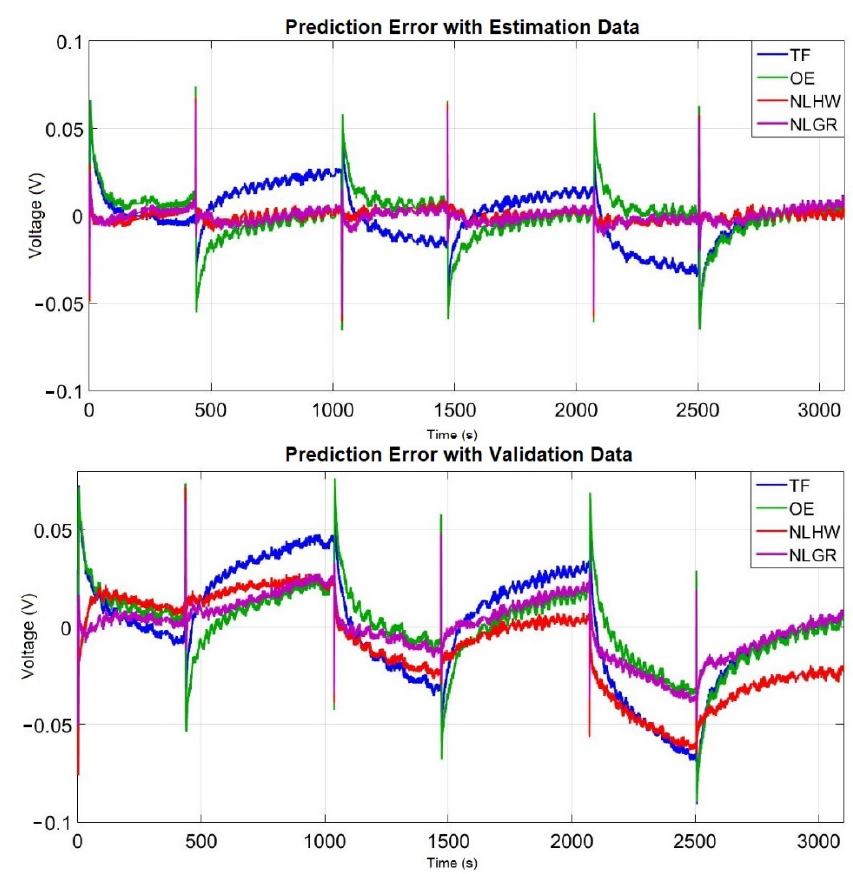
Figure 7. Prediction error with estimation data and validation data.